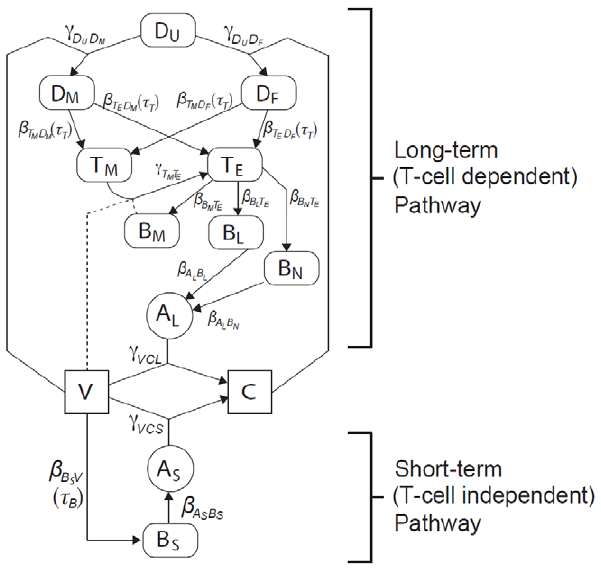
Figure 1. Schematic of the short-term and long-term dynamics of the immune response, as stimulated by vaccine antigen. For variable definitions see Table 1; for parameter definitions and values see Table